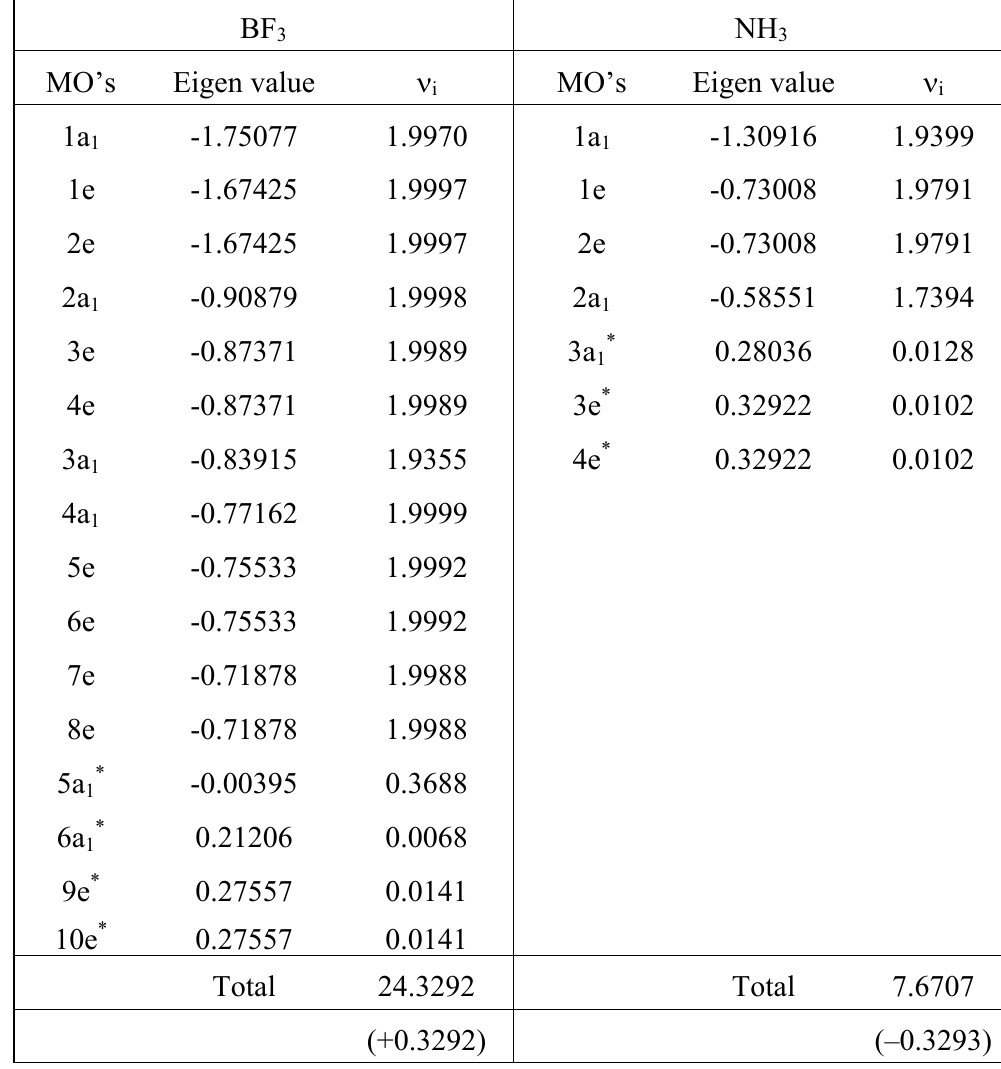
) of the molecular orbital, MO’s of BF i